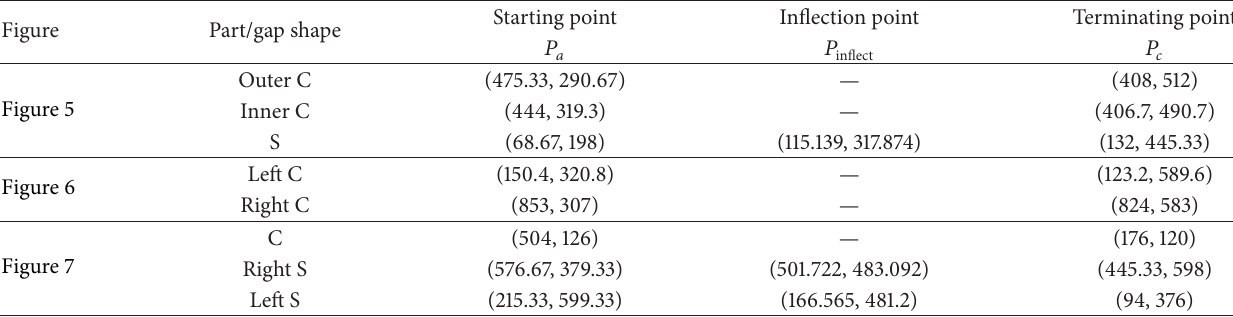
Table 1: The input data for LAC algorithm.